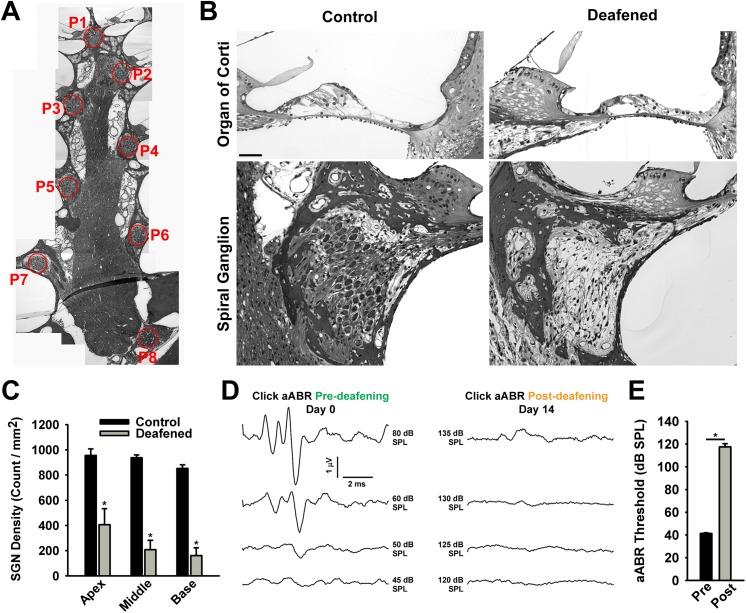
Efficacy of ouabain deafening in guinea pigs pre-implantation.A. Image collage of a mid-modiolar plastic section with positions of Rosenthal’s canal cross sections labelled from P1 to P8. (B) Representative images of spiral ganglia and the organ of Corti in untreated control (left) and ouabain deafened specimen (right, scale bar = 50 μm). SGN somata can be seen as dark round circles within the bony structure of the Rosenthal’s canal in control, but are depleted following ouabain treatment. Accompanying the loss of somata is a loss of fiber structures, which in control subjects project to organ of Corti and modiolus. (C) Quantification of SGN depletion along the cochlear axis from apex to base (control: n = 4, deafened: n = 5, * p < 0.001 for each region). (D) Click aABR waveforms elicited at increasing sound pressure levels (SPL) in a guinea pig pre- and post-deafening. (E) Quantification of aABR thresholds shows significant threshold elevation by ouabain treatment (* p = 0.01, n = 19), confirming efficient deafening at a physiological level. The pre-implantation deafening data include animals from sham, 1 and 2 month cell-free scaffold and 1 month NPC-scaffold groups. Error bars represent standard error of the mean.